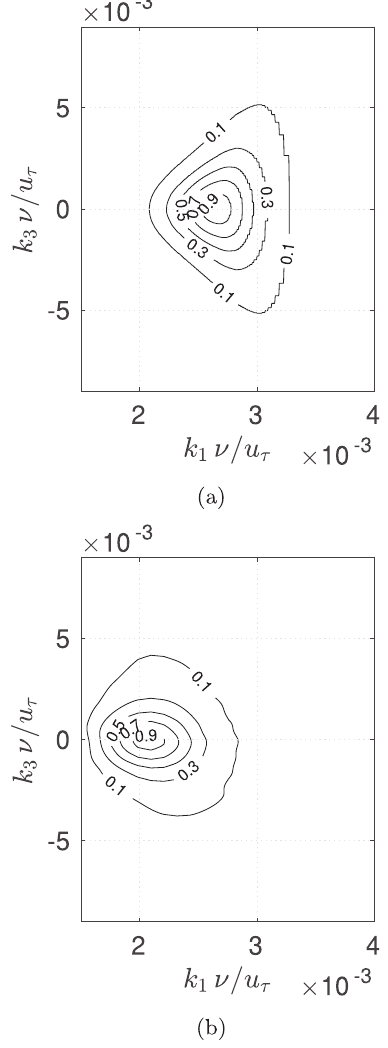
Figure 11. Contour levels of the spectra ’ s convective ridge for (a) modelled and (b) experimental data at x + = 0.05, Re + = 1.5 (cid:3) 10 3 and b P =